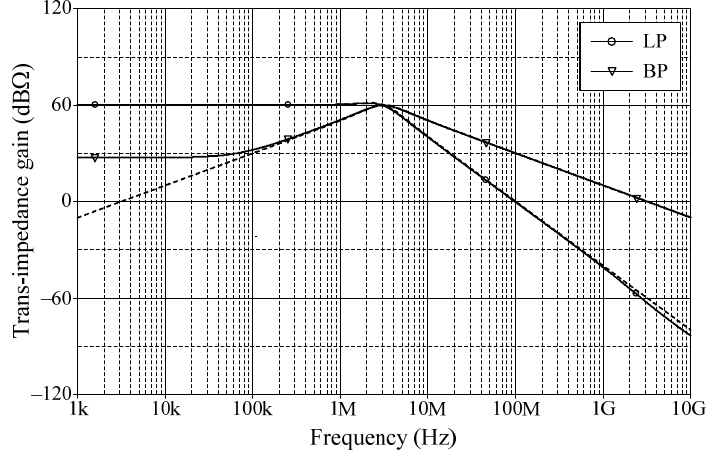
Figure 9. LP and BP frequency characteristics for TIM (simulated in solid line, theoretical in dashed line).